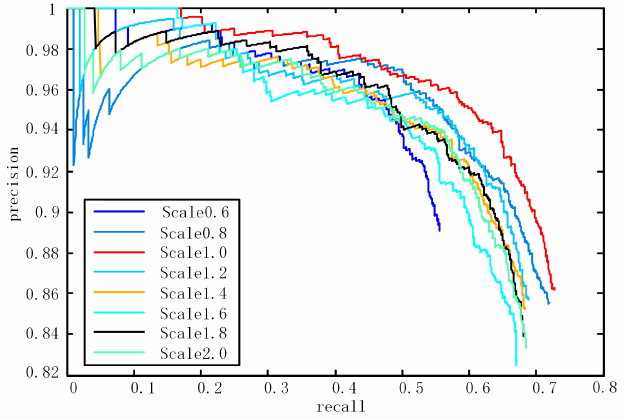
Figure 10. Performance after rescaling the image with different factors.